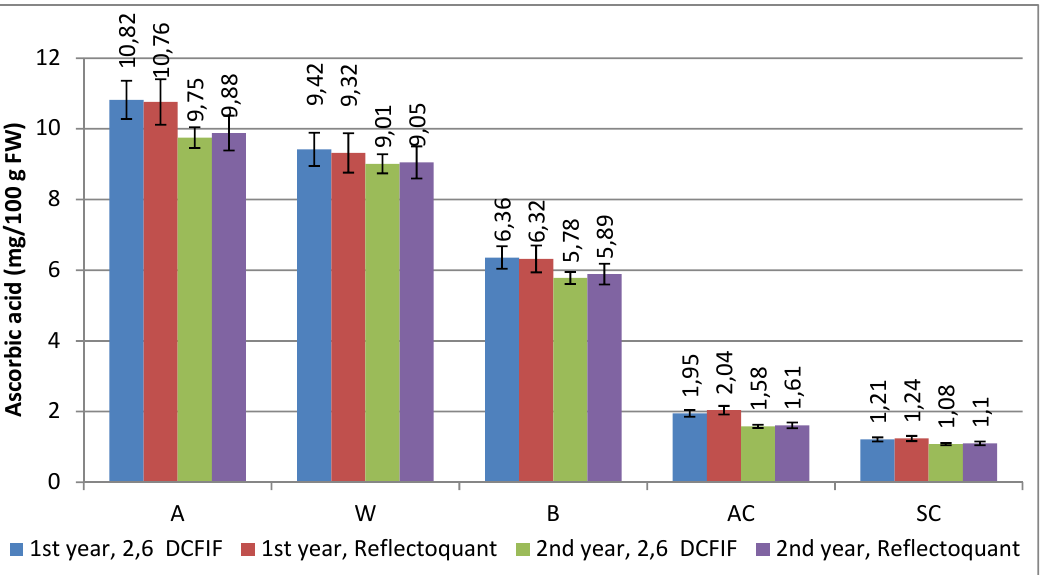
Figure 2. Dynamics of ascorbic acid content during the technological flow of apricot compote fabrication: apricot raw material (A), washed fruits (W), after blanching (B), apricots from compote (AC), and syrup from compote (SC), during two different years and employing 2,6 dichlorophenol indophenol and Reflectoquant methods. Results are means of 3 determinations±standard